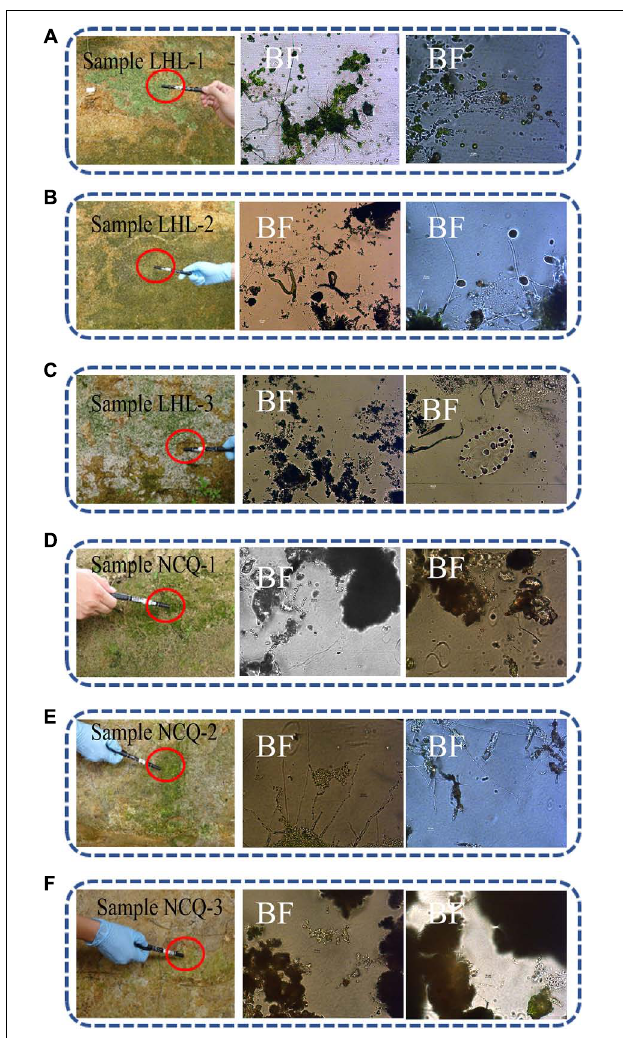
FIGURE 4 | Sampling sites for microbiological analyses on the surfaces of six objects showing visible microbial contamination. (A–F) Details of samples LHL-1, LHL-2, LHL3, NCQ-1, NCQ-2 and NCQ-3. Visible signs of biofilm were present on the six samples; BF, bright field. In the bright field, a large number of green tissue structures, insect traps, beaded fungal hyphal structures and algae were